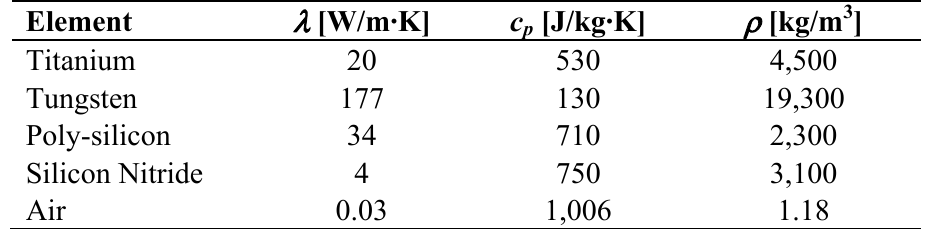
Table 1. Properties of constituent’s